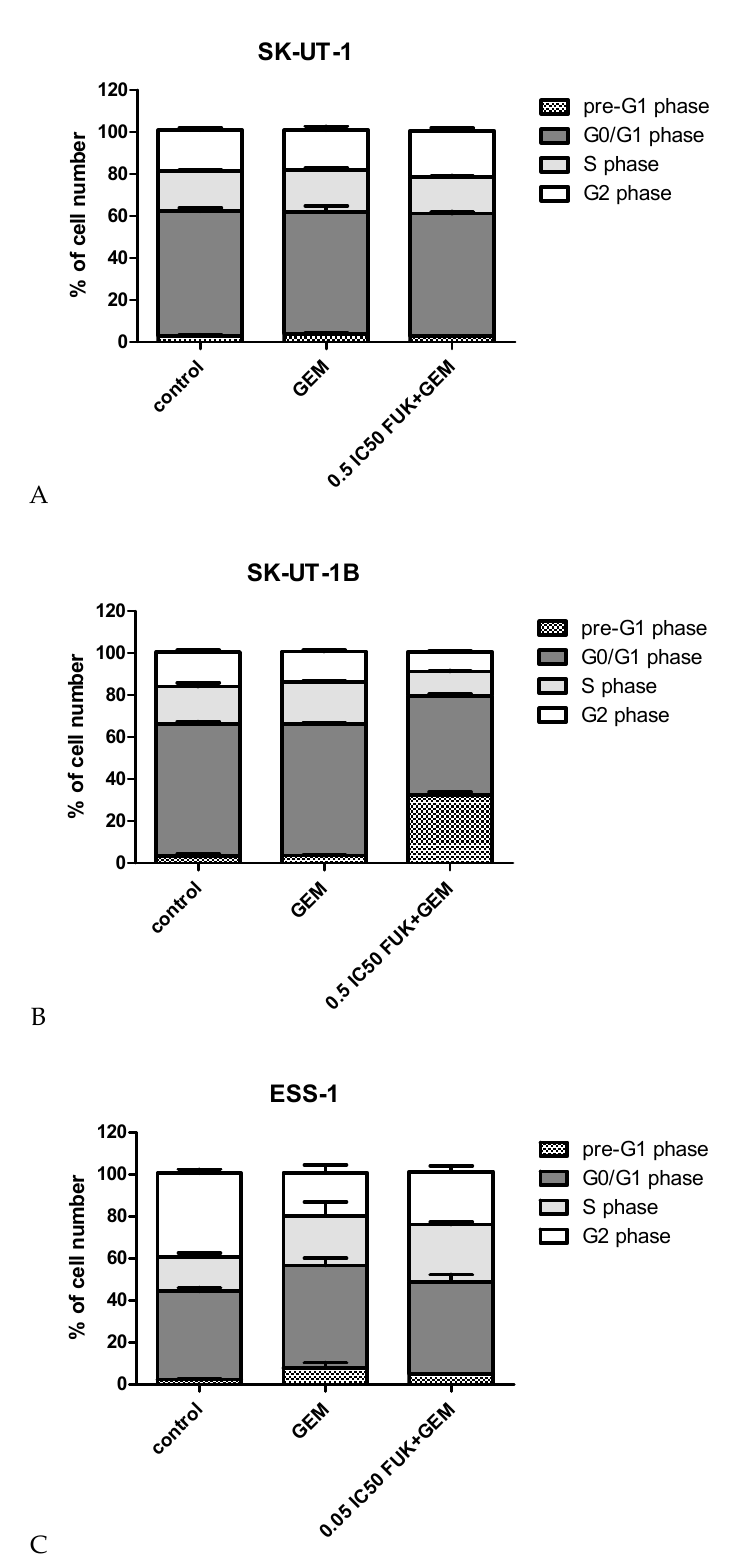
Figure 7. Effects of gemcitabine (in IC 50 concentration) and mixture of fucoidan and gemcitabine (in concentrations of 0.5 IC 50 for SK-UT-1 and SK-UT-1B and 0.05 IC 50 for ESS-1) on cell cycle progression in SK-UT-1 ( A ), SK-UT1-B ( B ), and ESS-1 ( C ) cell lines. The results are presented as mean ± SD from three separate experiments.